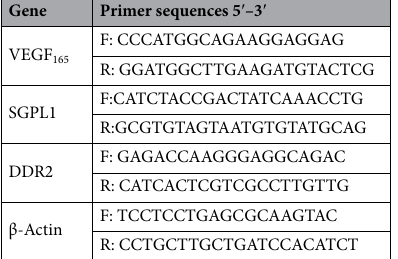
Table 1. Designed primers used in